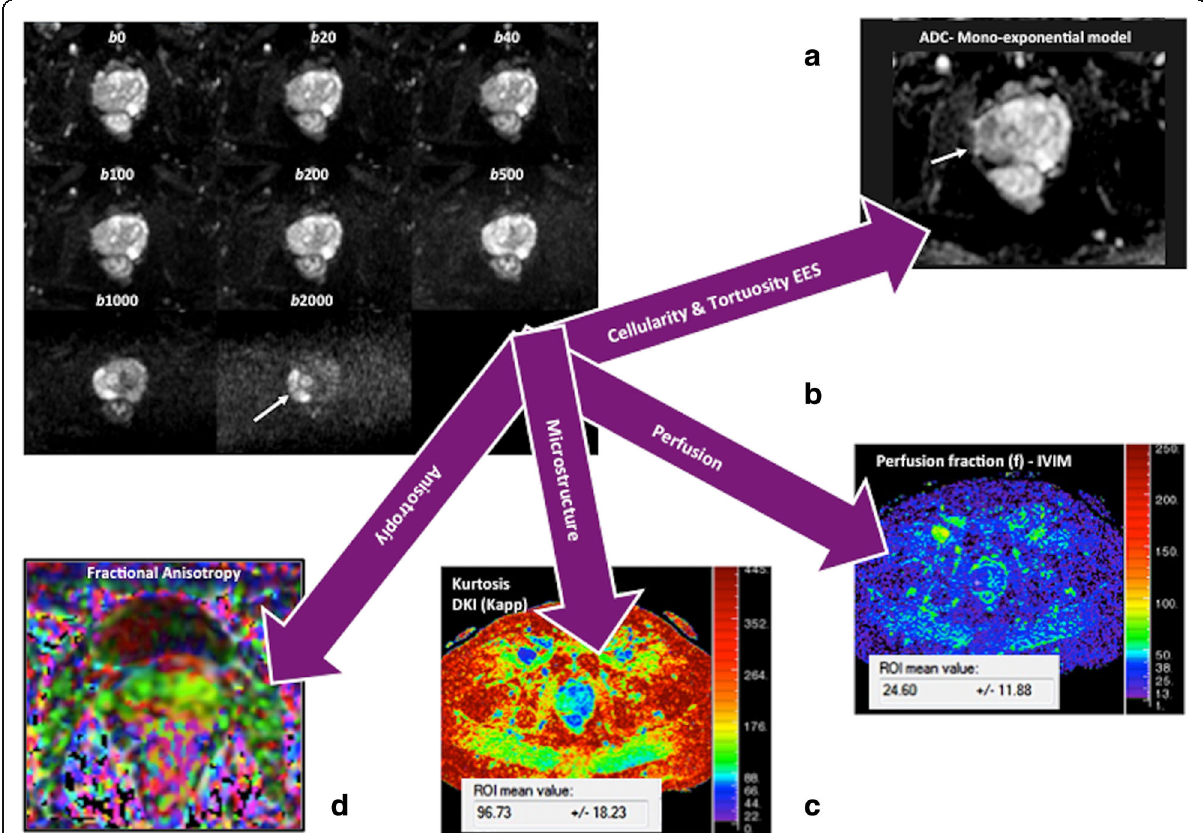
Fig. 3 A 69-year-old man with Gleason 4 + 3 prostate cancer (white arrows). Diffusion signal evaluated using different models of analysis: mono-exponential ( a ) intravoxel incoherent exponential model (IVIM) ( b ), diffusion kurtosis imaging (DKI) ( c ), and diffusion